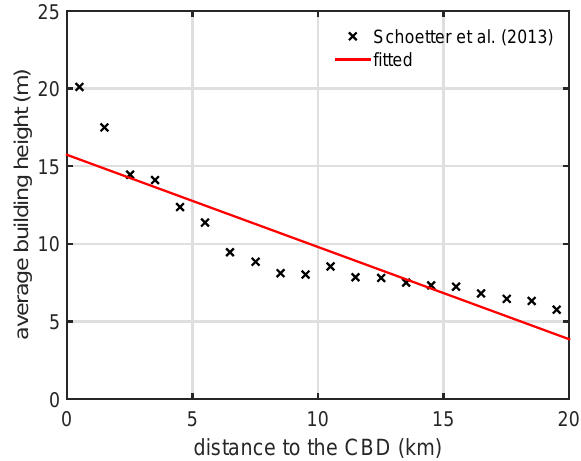
Figure 3. Average building heights as a function of distance to the CBD (Coordinates: 53.5488 ◦ N, 9.9913 ◦ W) for Hamburg. The average is calculated from building height data of a study by Schoetter et al. [4] using 1 km bins (i.e., 0 km–1 km, ..., 19 km–20 km). The red line shows the linear fit, which has an explained variance R 2 of